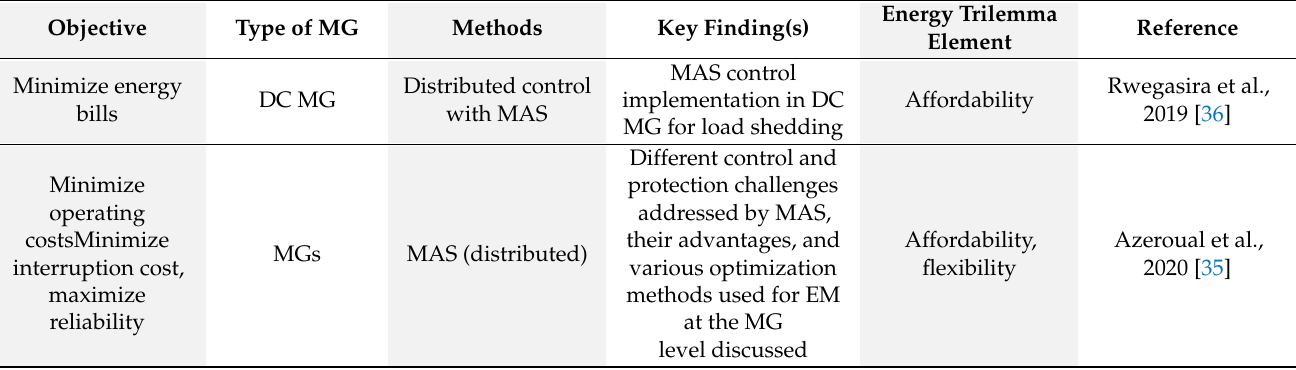
Table 3. MAS control methods for EMS in MGs and perspective of energy